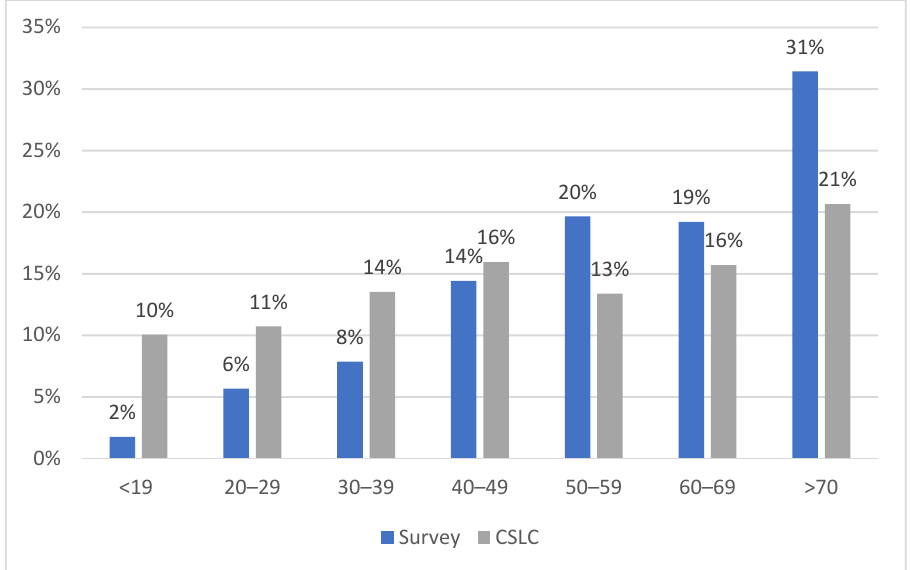
Figure 4. Distribution by age (comparison of our survey data and Comprehensive Survey of Living Conditions (CSLC)).